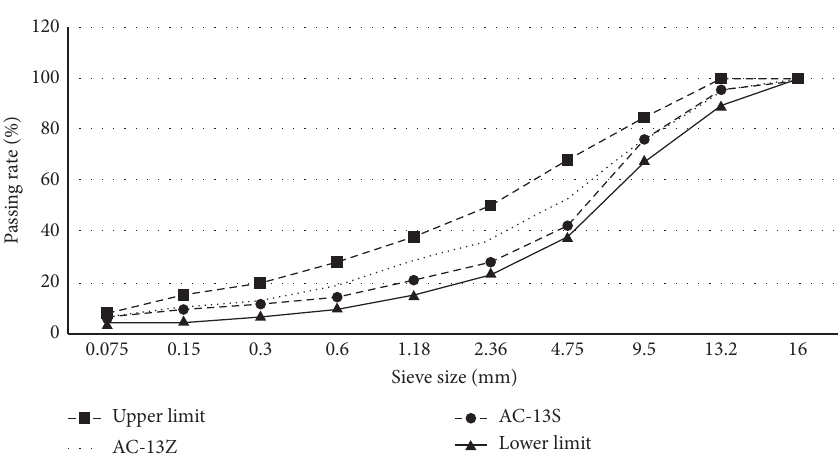
Figure 1: Gradation